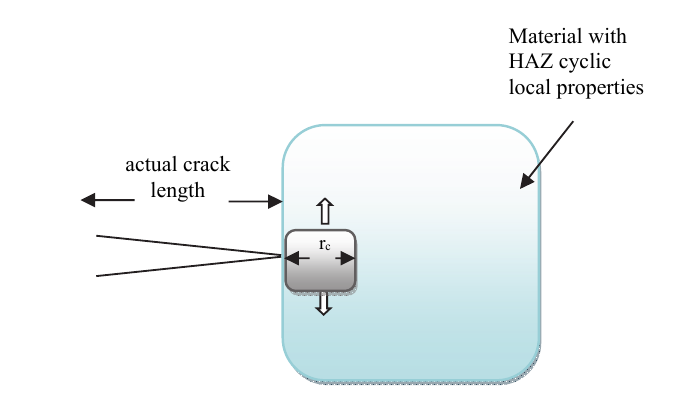
Figure 1: Incremental crack growth in